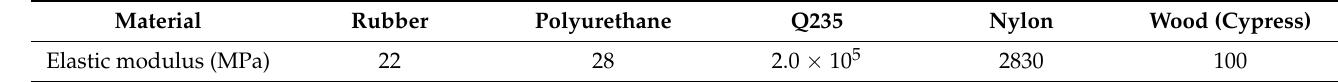
Table 1. Test results of elastic modulus of different